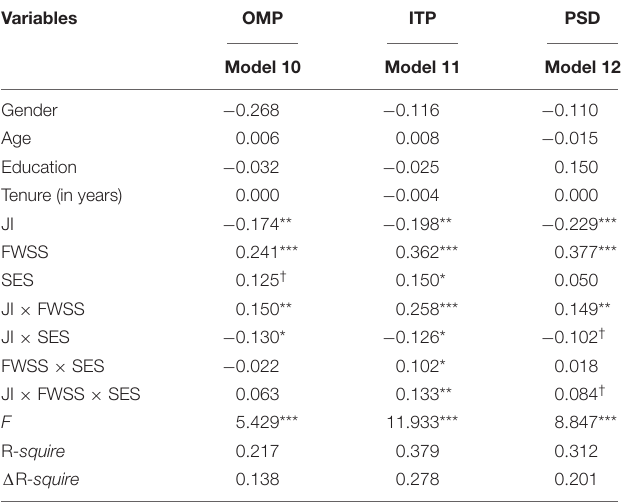
TABLE 4 | Hierarchical regression results of three-way interactive role on proactive